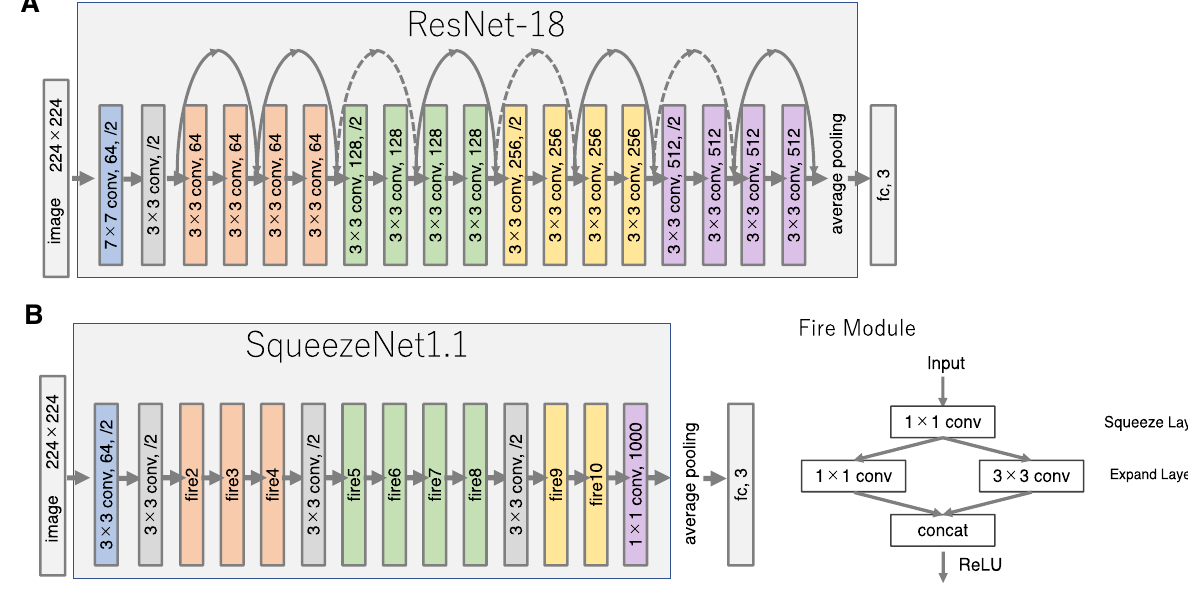
Figure 2. Schematic representations of transfer learning architectures. ( A ) ResNet-18. ( B )